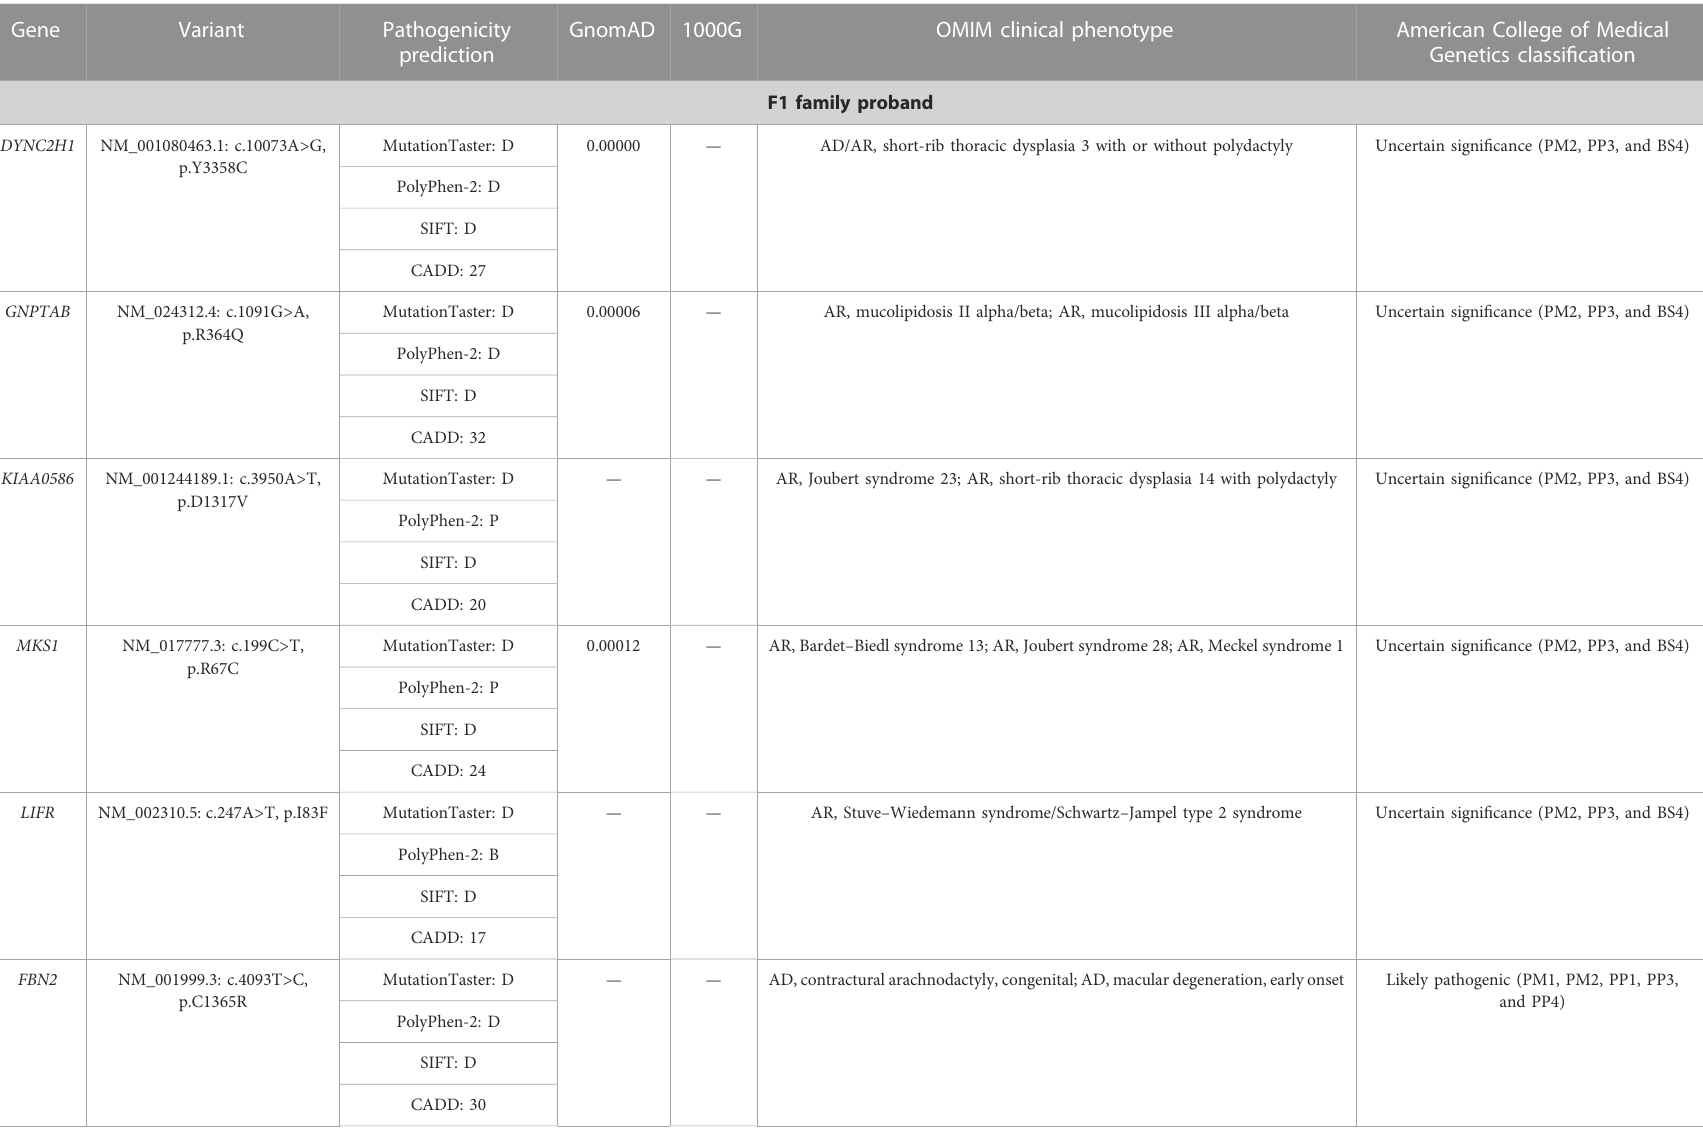
TABLE 2 Variants identi fi ed in the two probands by WES in combination with the fi ltration of skeletal dysplasia – related genes.